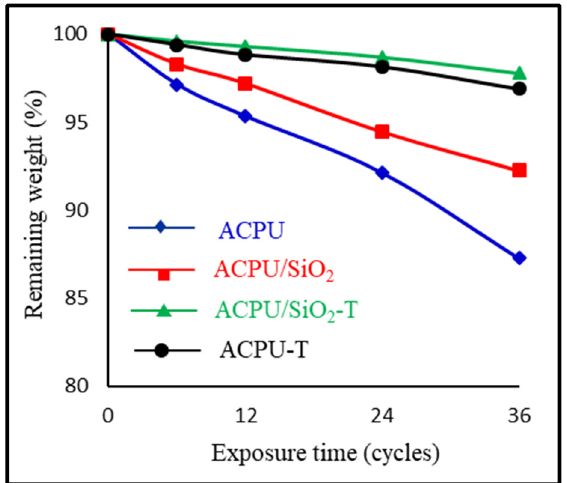
Figure 6. Changes in weight of the coatings under accelerated weathering aging condition.